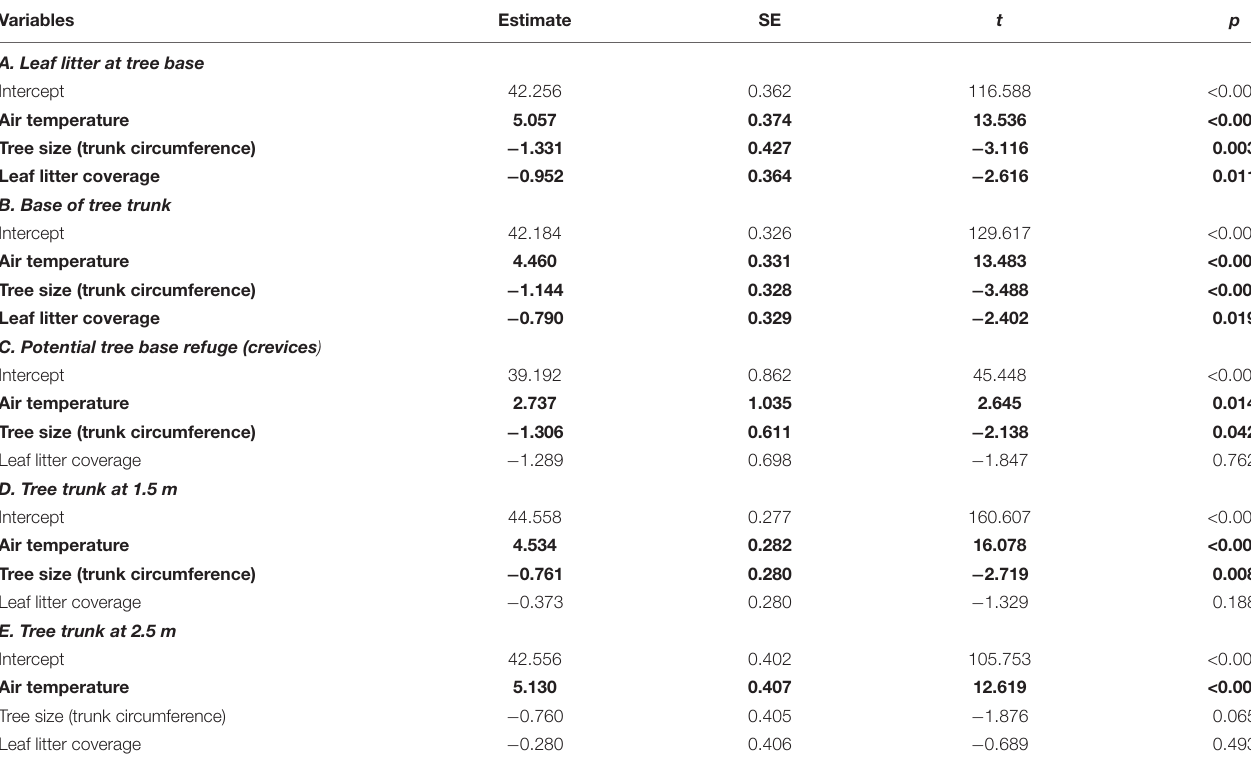
TABLE 5 | Results from linear models (lm) testing for factors associated with surface temperatures of mallee eucalypt trees, at air temperatures > 35 ◦ C. Variables Estimate